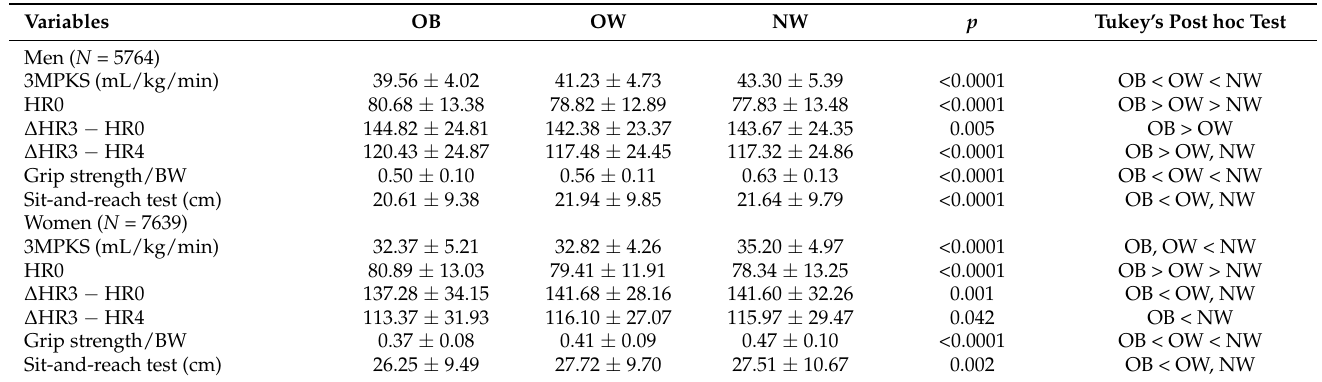
Table 2. Scientific physical fitness measurements according to different obesity statuses among adults in Taiwan.